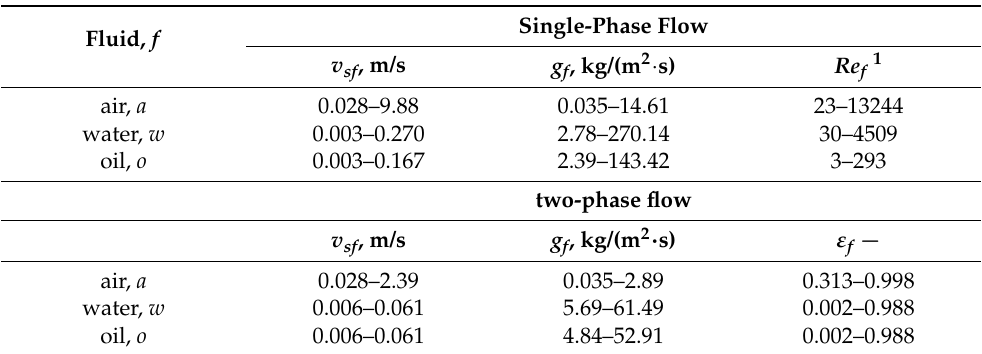
Table 5. Range of experimental